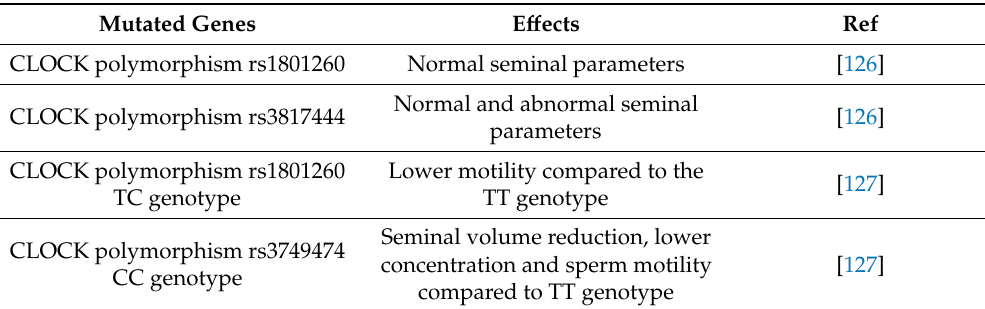
Table 5. E ff ect of mutated genes on human male